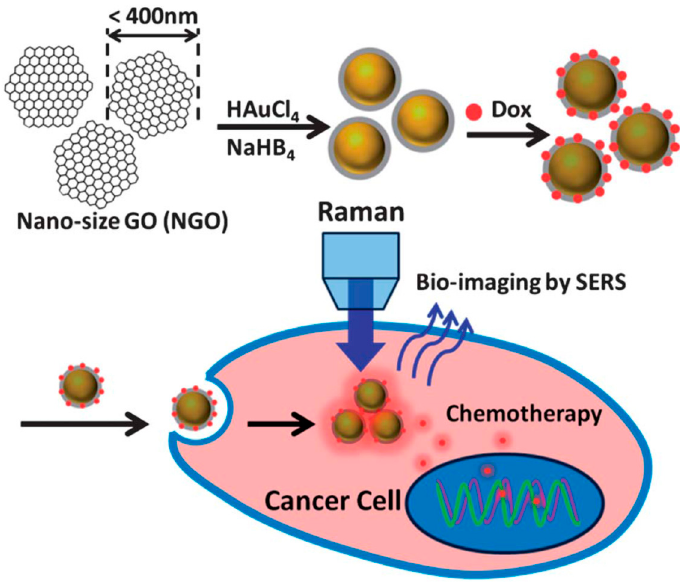
Figure 3. Schematic illustration of surface enhanced Raman scattering (SERS) based imaging and anticancer drug delivery by using Au@GO. Reproduced with permission from [79]. Copyright Royal Society of Chemistry, 2014.